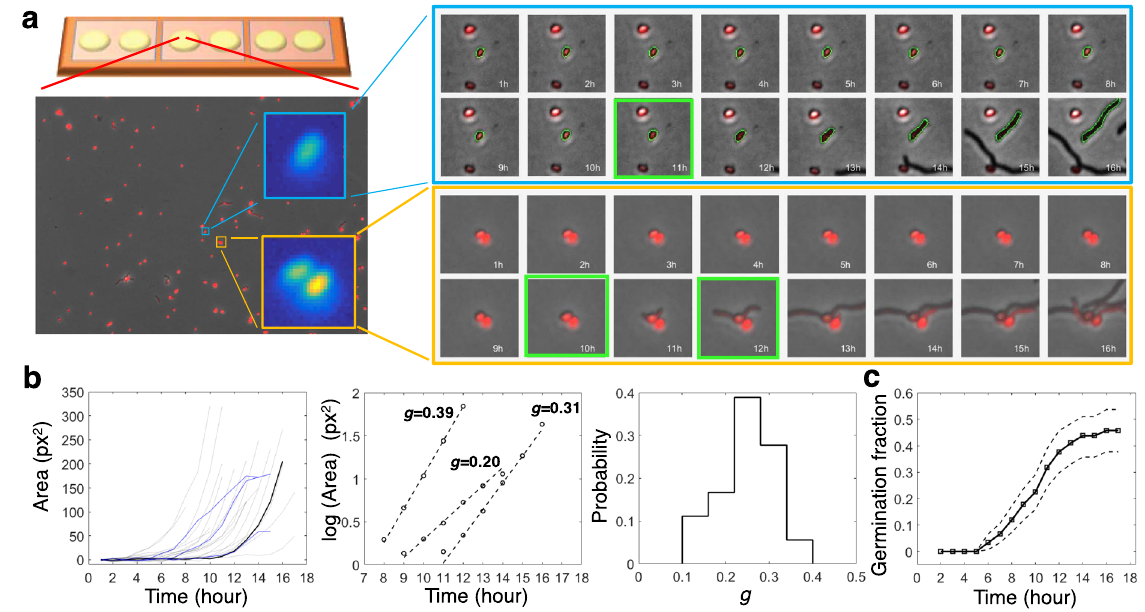
Figure 1. Platform for high-throughput quantification of phenotypic variability of germination and early growth. ( a ) A device containing multiple agar wells was used to monitor germination of fluorescent spores over time in parallel communities. Up to 40 fields of view per well were imaged for up to 24 hours. Individual spores were identified and, if clustered, segmented based on their fluorescent intensity. Shown are time-lapse images for an individual spore (blue, top) and a pair of touching spores (orange, bottom). The outlines of spores and emerging mycelium tubes were identified through image processing (green contours). The germination time was determined as the onset of spore elongation (green frame). ( b ) Analysis of initial growth of individual spores. (Left) Plot of area growth as a function of time reveals a lag phase followed by an exponential growth phase (the individual spore from ( a ) is shown in dark black). In some cases, the growth of mycelium stalled (blue). (Middle) Initial growth rate, g , was deduced by fitting a line to log(area) versus time. (Right) The distribution of growth rates of all growing spores from the field of view shown in ( a ). ( c ) The cumulative fractions of germinated spores over time for all 151 spores from the field of view shown in ( a ). Dashed curves indicate the 95% confidence interval for the germination